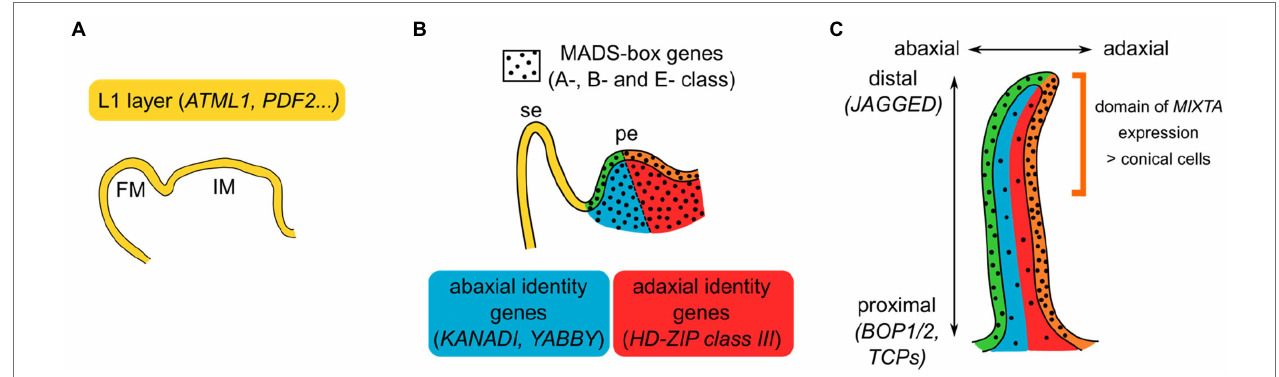
FIGURE 2 | Model for the combinatorial specification of petal identity and polarities. (A) In the inflorescence and flower meristems (IM and FM, respectively), layer identity is already specified. In particular, the meristematic L1 layer and the epidermis that derives from it express a specific set of genes. (B) Initiating sepal (se) and petal (pe). Petal identity is defined by the expression of B-class MADS-box genes, in a floral context defined by A- and E-class genes, in all layers of the petal primordia (black dots). Abaxial (blue) and adaxial (red) sides of the petal are specified by a set of genes. Intersection of epidermal identity with abaxial or adaxial identity results in petal subdomains represented in green and orange, respectively. (C) Developing petal. Layer identity and abaxial/adaxial polarity are still maintained, and proximo-distal polarity establishes as the petal grows. MADS-box genes expression is not necessarily homogeneous in the developing petal: here is depicted the case of Arabidopsis SEP3 protein, enriched in the petal epidermis and particularly on its adaxial side. The combination of these different positional signals can result in the specification of distinct cell fates: In snapdragon, MIXTA is only expressed in the epidermal, adaxial, and distal part of the petal, driving there the formation of conical